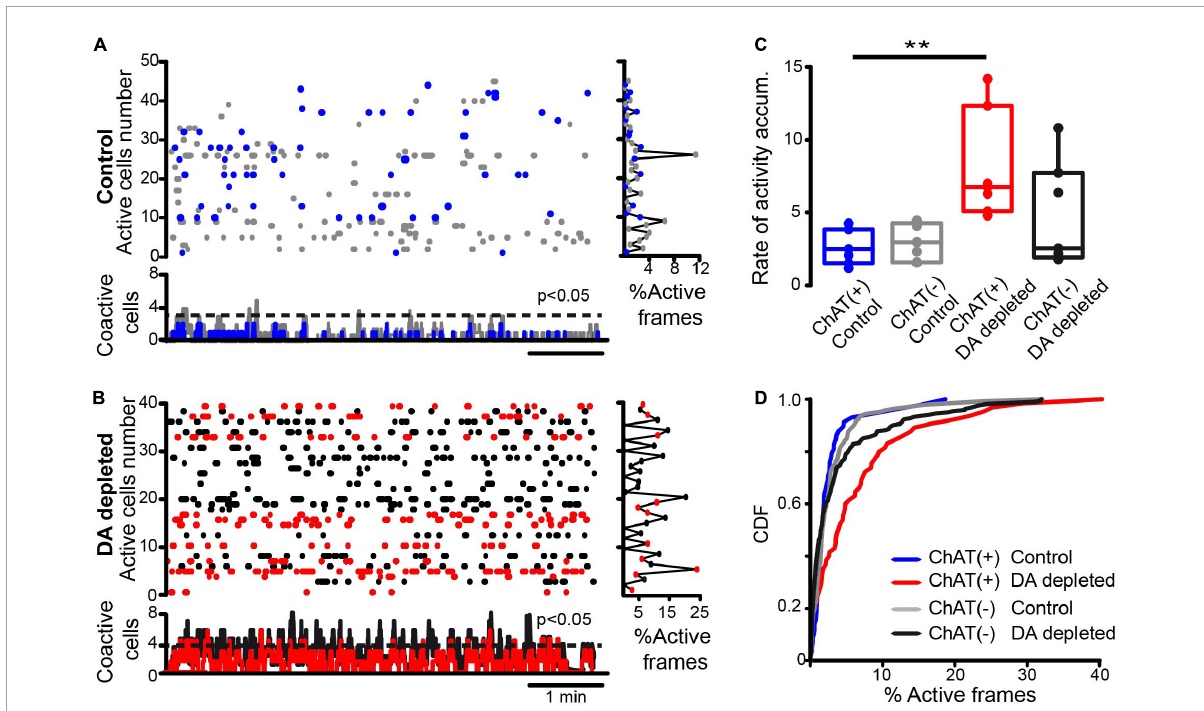
FIGURE1 Spontaneous neuronal activity within striatal microcircuits in control and after dopamine depletion. (A) The raster plot shows the spontaneous activity of several neurons recorded simultaneously with calcium imaging in control conditions. Blue dots are identified CINs (tdTomato in ChAT-cre mice), and gray dots are presumably other neuron types. The right histogram shows activity per neuron (rows) and the histogram at the bottom shows coactivity (neurons that fire together in a column vector or movie frame). A dashed line indicates when a column vector is significant using Monte Carlo simulations ( P < 0.05). In control, significant peaks of coactivity are scarce and rarely coincide with CINs peaks. (B) Similar raster plots showing the spontaneous activity of several neurons recorded simultaneously in DA-depleted striatum: notice increased activity as compared to the control. Red dots are identified CINs. The right histogram shows increased activity per row. Histogram of coactivity at bottom exhibits numerous significant peaks of coactivity along time, these are often accompanied with CINs activity. (C) Box plots show that the rate of activity accumulation of CINs over time increases after DA depletion (see Material and methods; Supplementary Figure 2 ; Kruskal-Wallis ANOVA with post hoc Dunn’s test: ChAT + active neurons before (control) and after DA-depletion: ** P = 0.0087). (D) Cumulative distribution functions (CDFs) of activity of ChAT + and ChAT- neurons before and after DA depletion (control ChAT + vs. control ChAT- neurons: P = 0.76; control ChAT + vs. ChAT + after DA depletion: P < 0.0001; control ChAT- vs. ChAT- after DA depletion: P = 0.042; ChAT + vs. ChAT- after DA depletion: P < 0.0001 (n-control ChAT + = 58 neurons; n-control ChAT- = 146 neurons; n-DA-depleted ChAT + = 65 neurons, n-DA-depleted ChAT- = 222 neurons; from 7 different animals in both control and after DA depletion; Kolmogorov-Smirnov